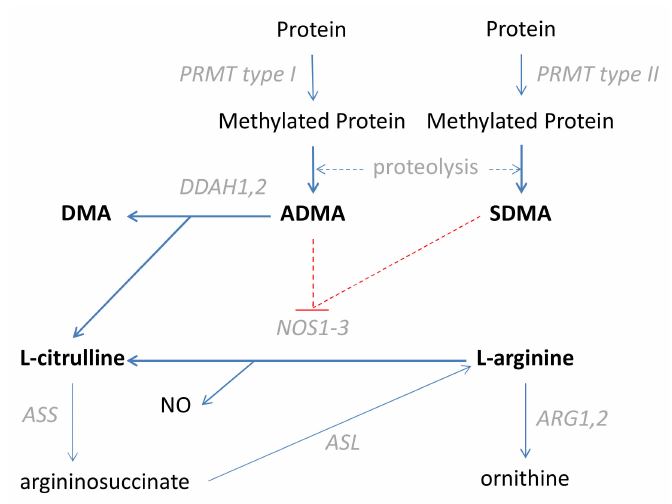
Figure 1. Simplified scheme of the L-arginine / nitric oxide (NO) pathway. Pathway metabolites analyzed in the current study are written in bold script. Key pathway enzymes are written in grey italics. The inhibitory e ff ect is marked in red dashed lines. PRMT: Arginine N-methyltransferase; CATs: Cationic amino acid transporters; DDAH: Dimethylarginine dimethylaminohydrolase;